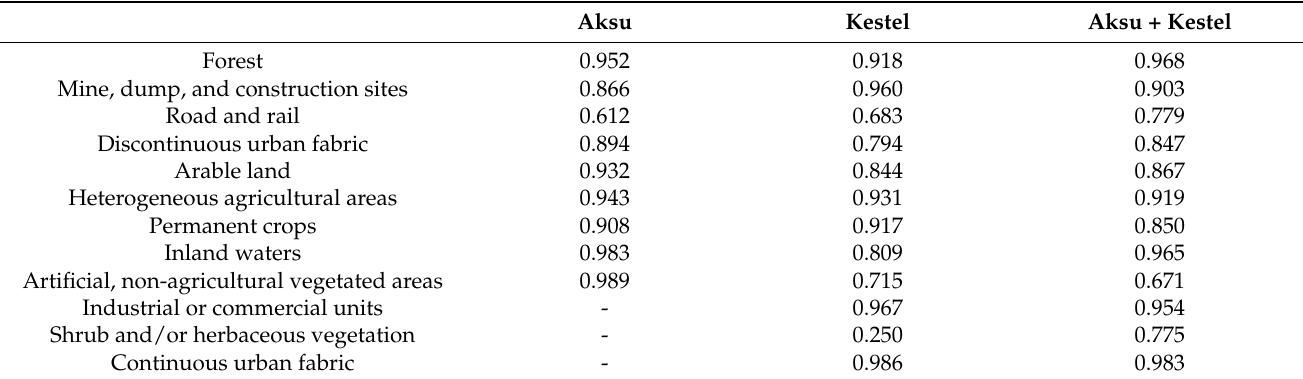
Table 5. Class-wise accuracy values obtained from different dataset